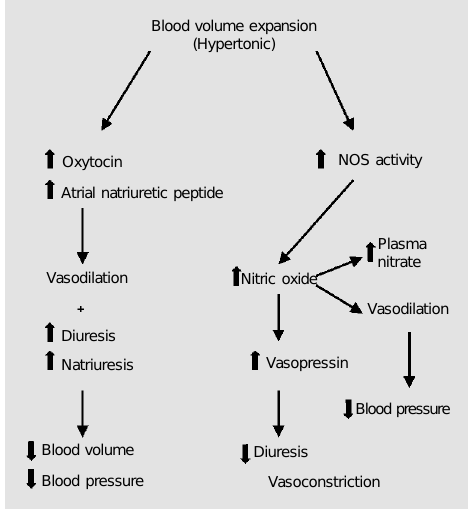
Figure 5. Schematic representation of hormonal changes, nitric oxide production and hemodynamic modifications after hypertonic blood volume expan- sion. NOS = nitric oxide